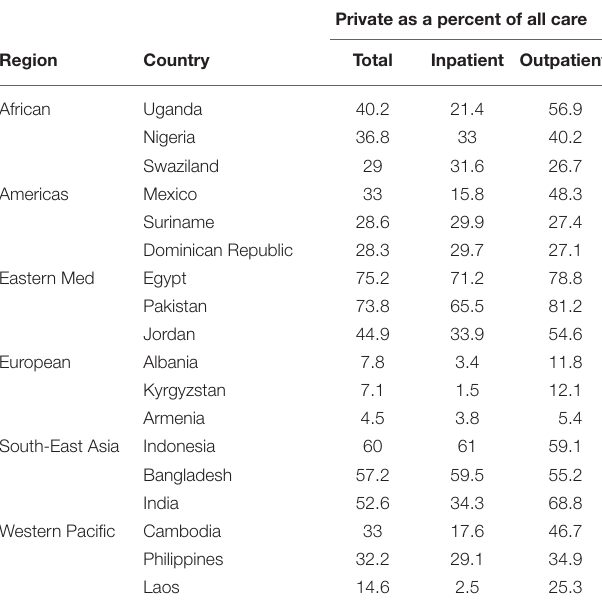
TABLE 3 | Ownership ratio by WHO region. PAHO